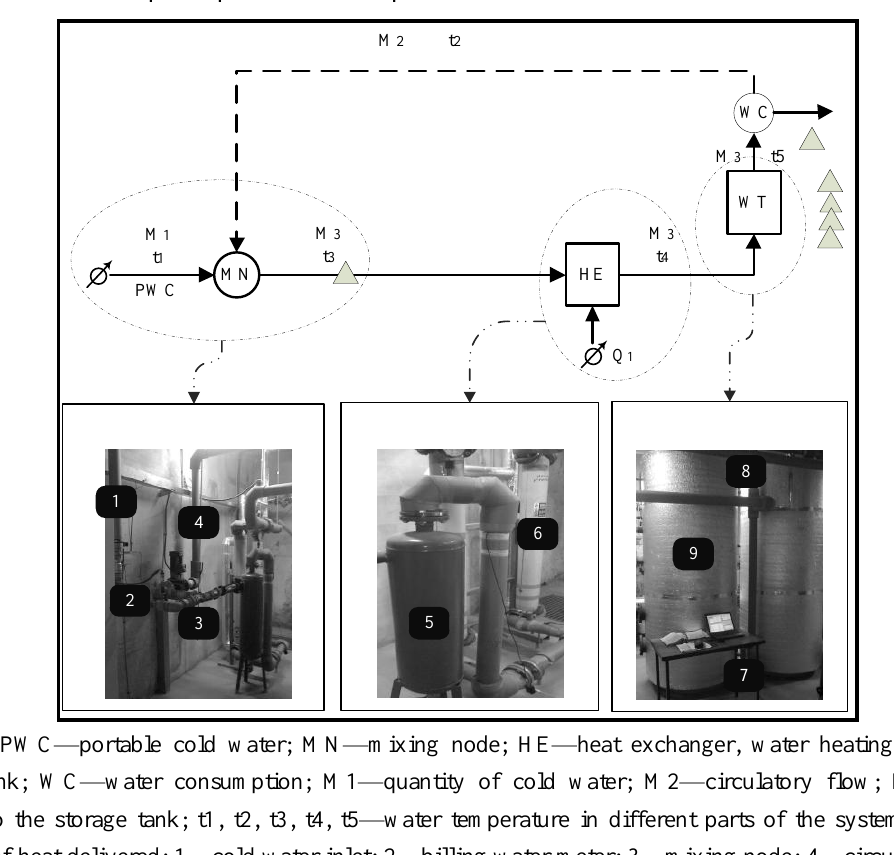
Figure 1. A Schematic diagram of the hot water exchanger with the locations where the simulation of water temperature was proposed and with the photographs of specific parts indicates a computer prediction